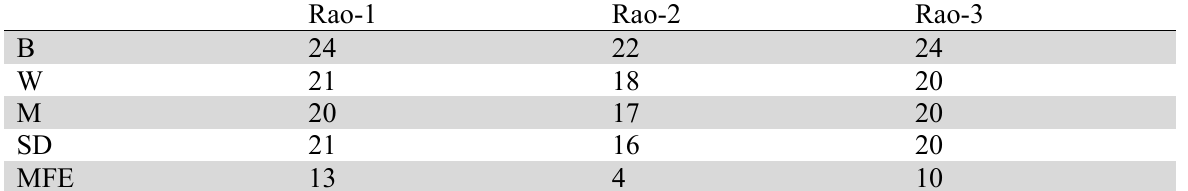
Table 18 shows the number of instances the results of each algorithm are either better or equal to the performance other algorithms in terms of best solution (B), worst solution (W), mean solution (M), standard deviation (SD) and mean function evaluations (MFE). Comparison of the results in terms of number of instances a particular algorithm is better than or equal in performance to other